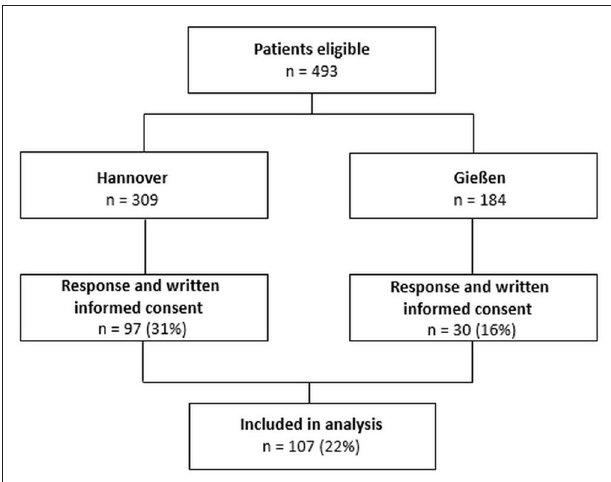
FIGURE 1 | Flowchart of participation.